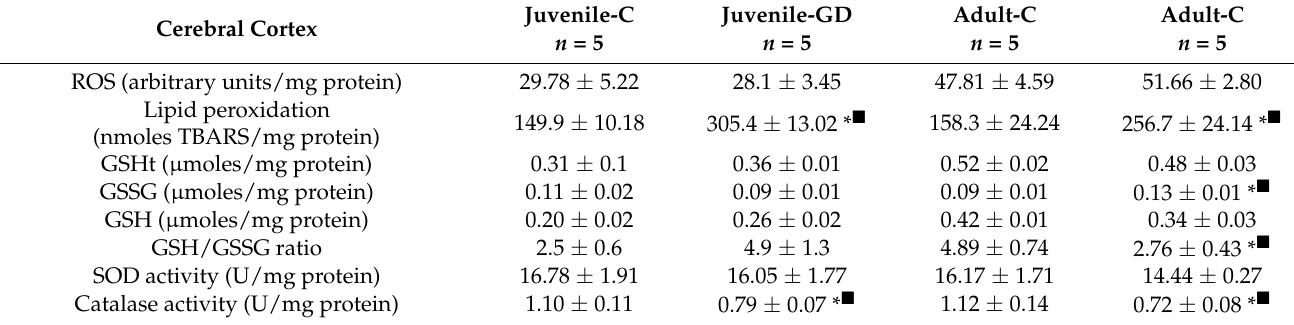
Table 3. Oxidative stress biomarkers of female second-generation